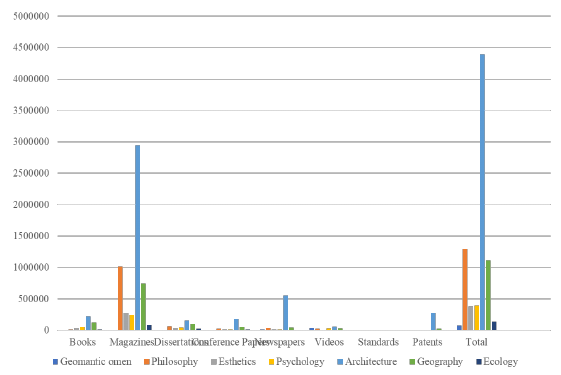
Table 4. Statistics of different types of subjects in the late Qing Dynasty (about 1644-1911) in